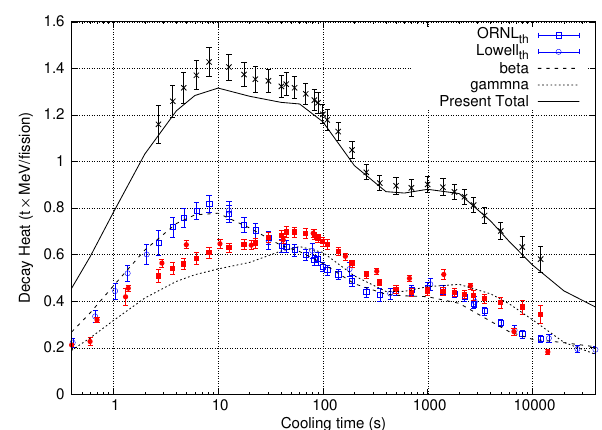
Figure 5. Decay heat as a function of the cooling time (s) cal- culated from the independent FPY by the summation calculation method. The experimental data of 235 U + thermal neutron are shown for comparison. Open symbols are decay heat released from β , filled symbols are that from γ , cross symbols represent the total energy